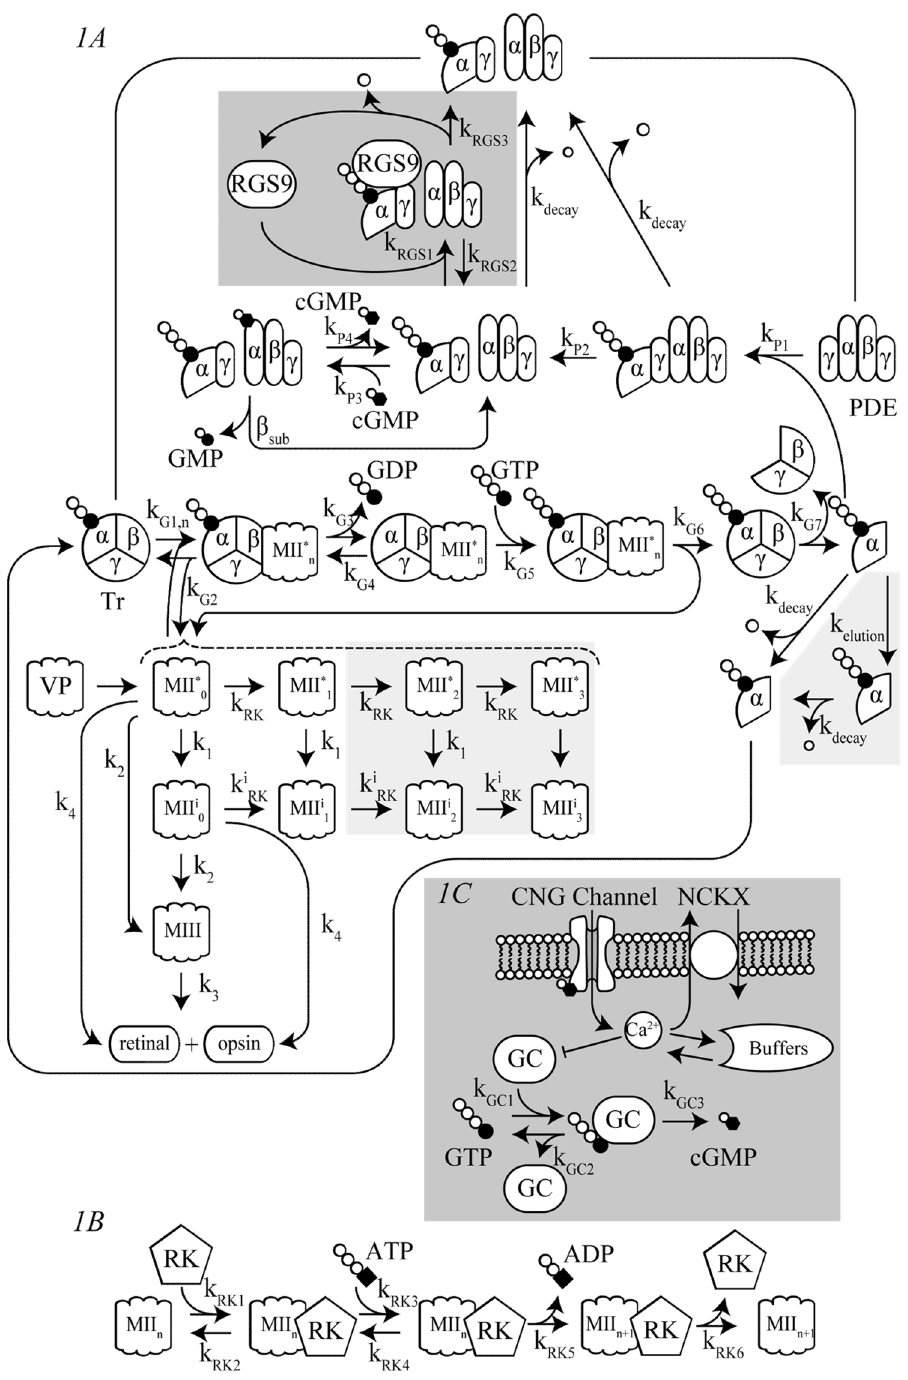
Figure 1. Reaction scheme of visual phototransduction in rods and cones. ( A ) Visual phototransduction, including activation and inactivation of VP, Tr, and PDE, in rods and cones (see Table 2 for abbreviations). ( B ) Details of the phosphorylation reactions. Phosphorylation of VP at 3 sites in vitro (Figs. 2, 3, 4), where only 1 site in vivo (Fig. 5) was assumed. Phosphorylation reactions and Tr* elution indicated in light gray were not included. C, RGS9-dependent inactivation of Tr* and GC-dependent cGMP synthesis, depicted in dark gray, were added for simulating I CNG in Fig.